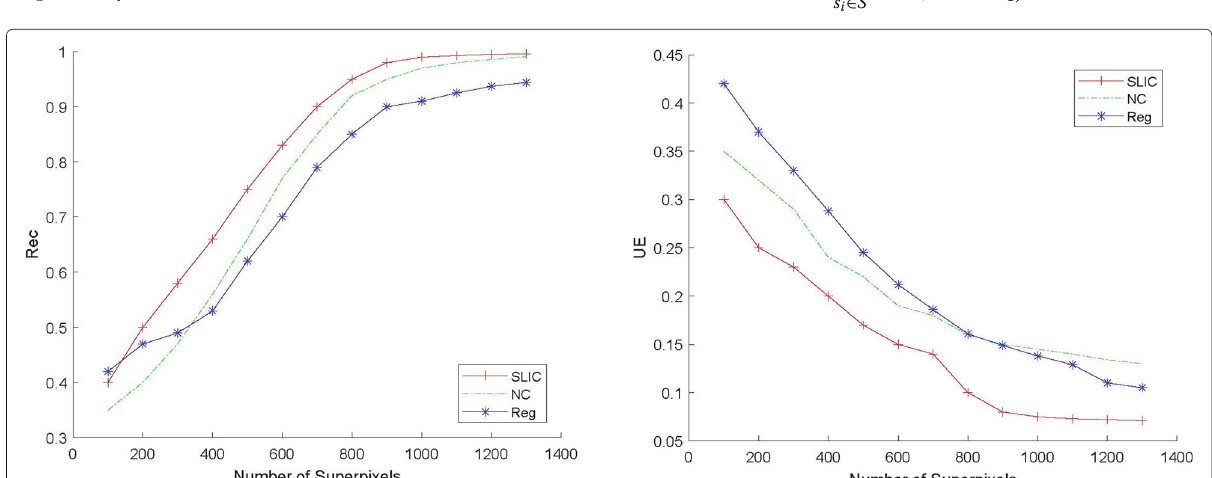
Fig. 3 Qualitative evaluation of superpixel algorithms on the DCT image